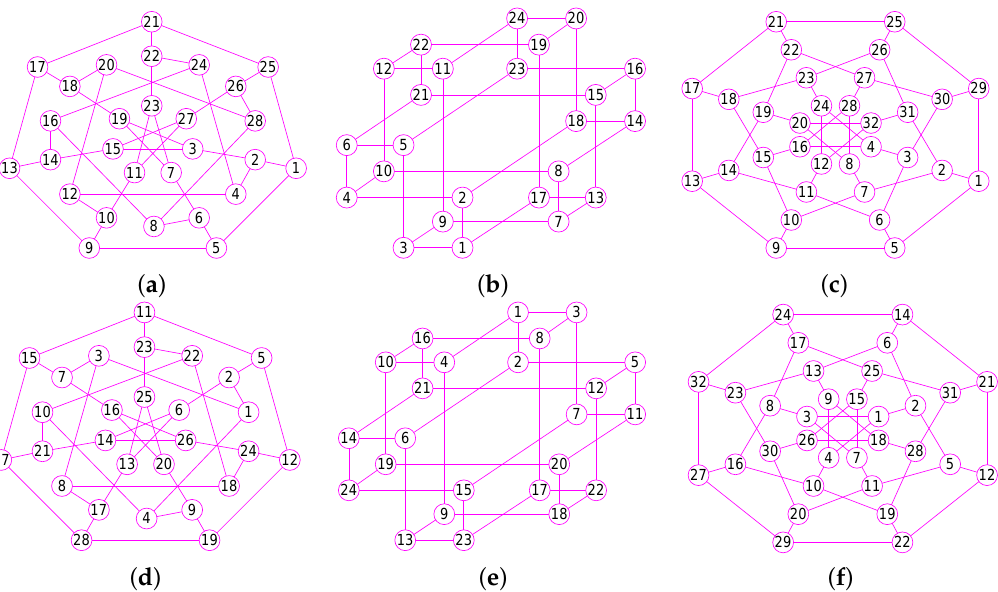
Figure 17. The TopMost graphs of three graphs G 22 , G 23 and G 24 . ( a ) The coxeter graph G 22 of 28 vertices and 42 edges; ( b ) The Nauru graph G 23 with 24 nodes and 36 edges; ( c ) The Dyck graph G 24 of 32 nodes and 48 edges; ( d ) The TopMost graph of G 22 ; ( e ) The TopMost graph of G 23 ; ( f ) The TopMost graph of G 24 .